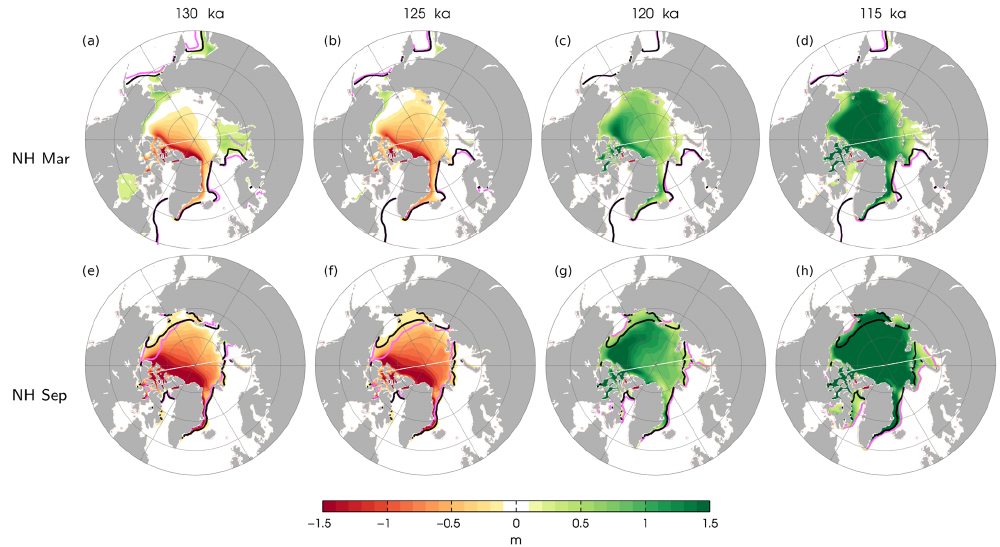
Figure 9. Simulated changes of Arctic sea ice thickness for the four Eemian experiments relative to the pre-industrial experiment. Panels (a) – (d) and (e) – (h) show the sea ice changes in March and September, respectively. The columns show the sea ice changes for the 130, 125, 120, and 115ka experiments from left to right. The solid magenta and black contour lines show the 15% sea ice concentration for each Eemian experiment and the pre-industrial experiment, respectively. Model results are annual means from the last 100 years of model integration. A latitude/longitude grid is indicated with gray lines with a 10/60 ◦